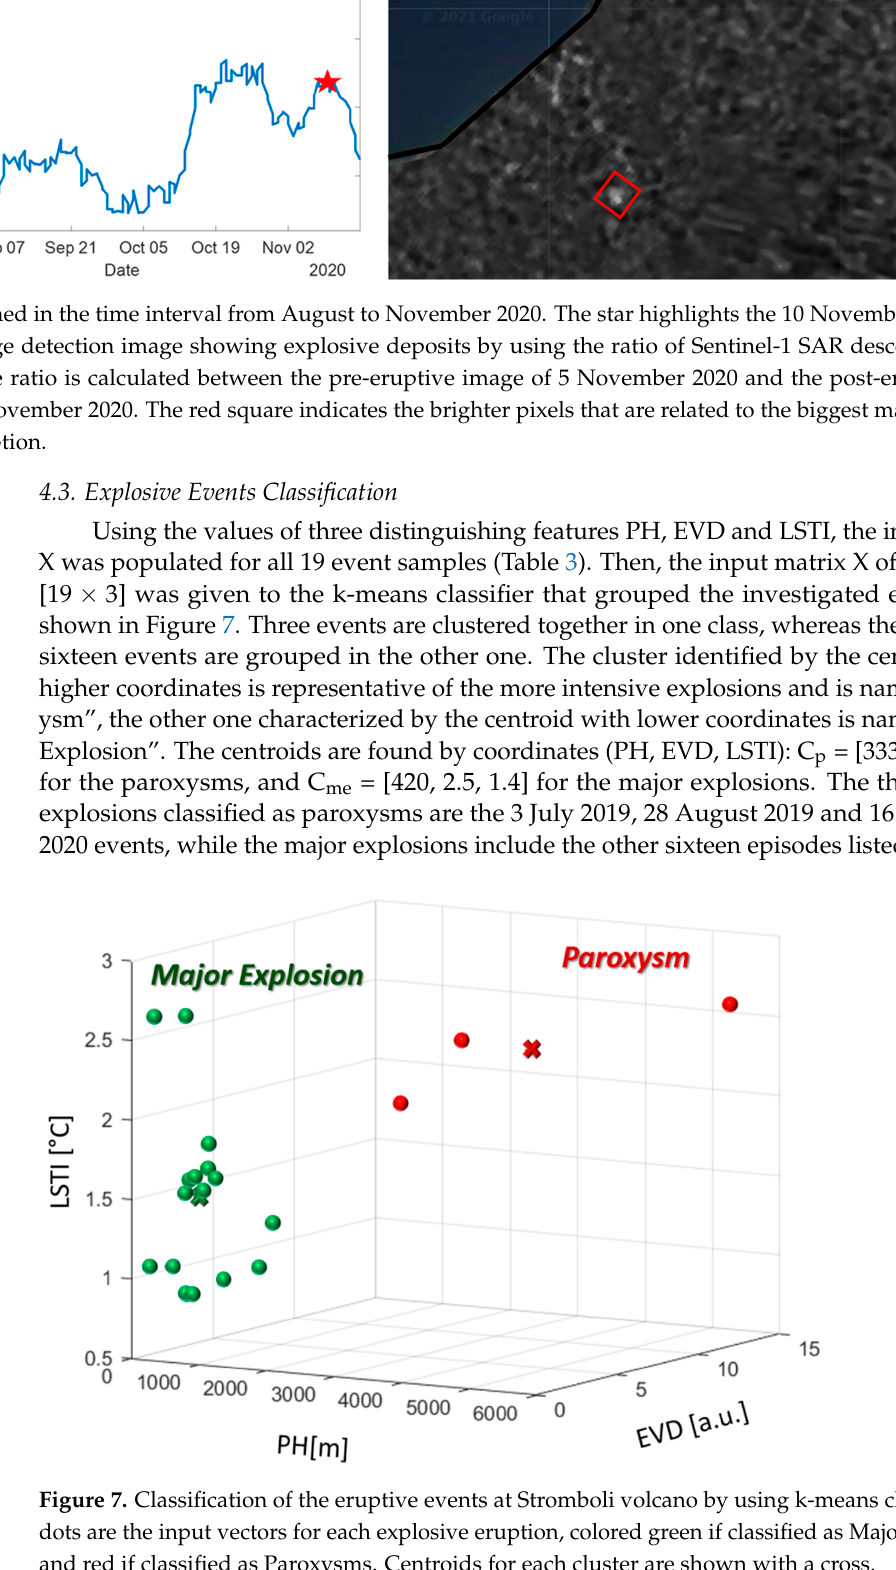
Table 3. List of the input features and classification outcome between “paroxysm” and “major explosion” for each eruptive event at Stromboli volcano. Date and time in dd/mm/yyyy hh:mm:ss format. Time is expressed in UTC.